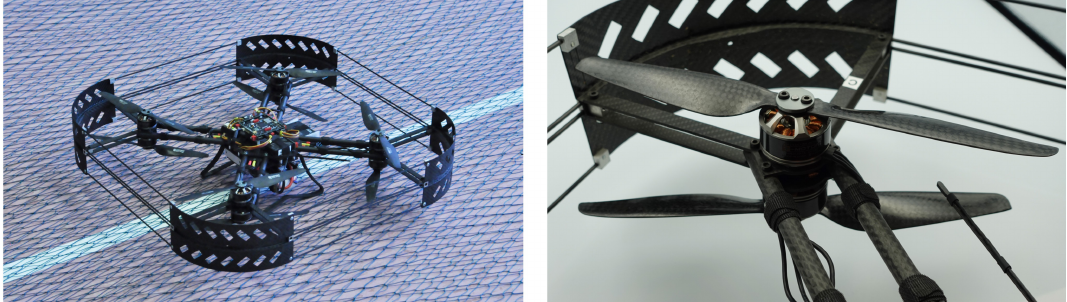
Figure 3. The Falcon V5 UAV used for FDI experiments and a detailed view of the coaxial propul- sion